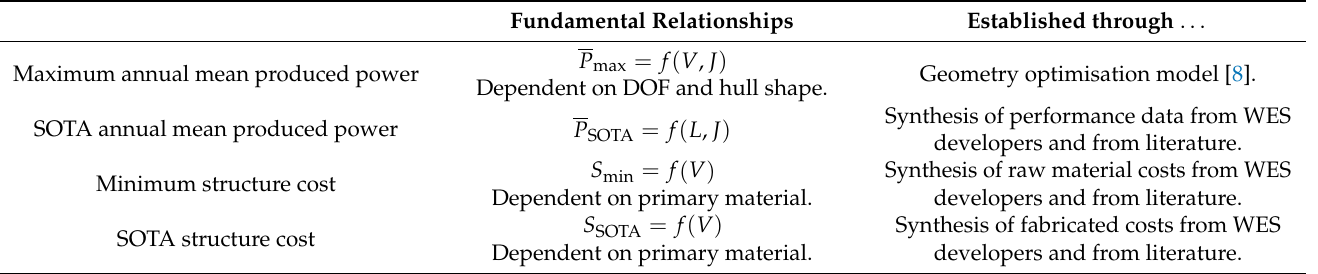
Table 5. Thresholds used for filtering and the assumed relationships used to calculate them, where V is the hull volume. Fundamental Relationships Established through . . . P max = f ( V , J ) Maximum annual mean produced power Geometry optimisation model [8]. Dependent on DOF and hull shape. Synthesis of performance data from WES SOTA annual mean produced power P SOTA = f ( L , J ) developers and from literature. S min = f ( V ) Synthesis of raw material costs from WES Minimum structure cost Dependent on primary material. developers and from literature. S SOTA = f ( V ) Synthesis of fabricated costs from WES SOTA structure cost Dependent on primary material. developers and from